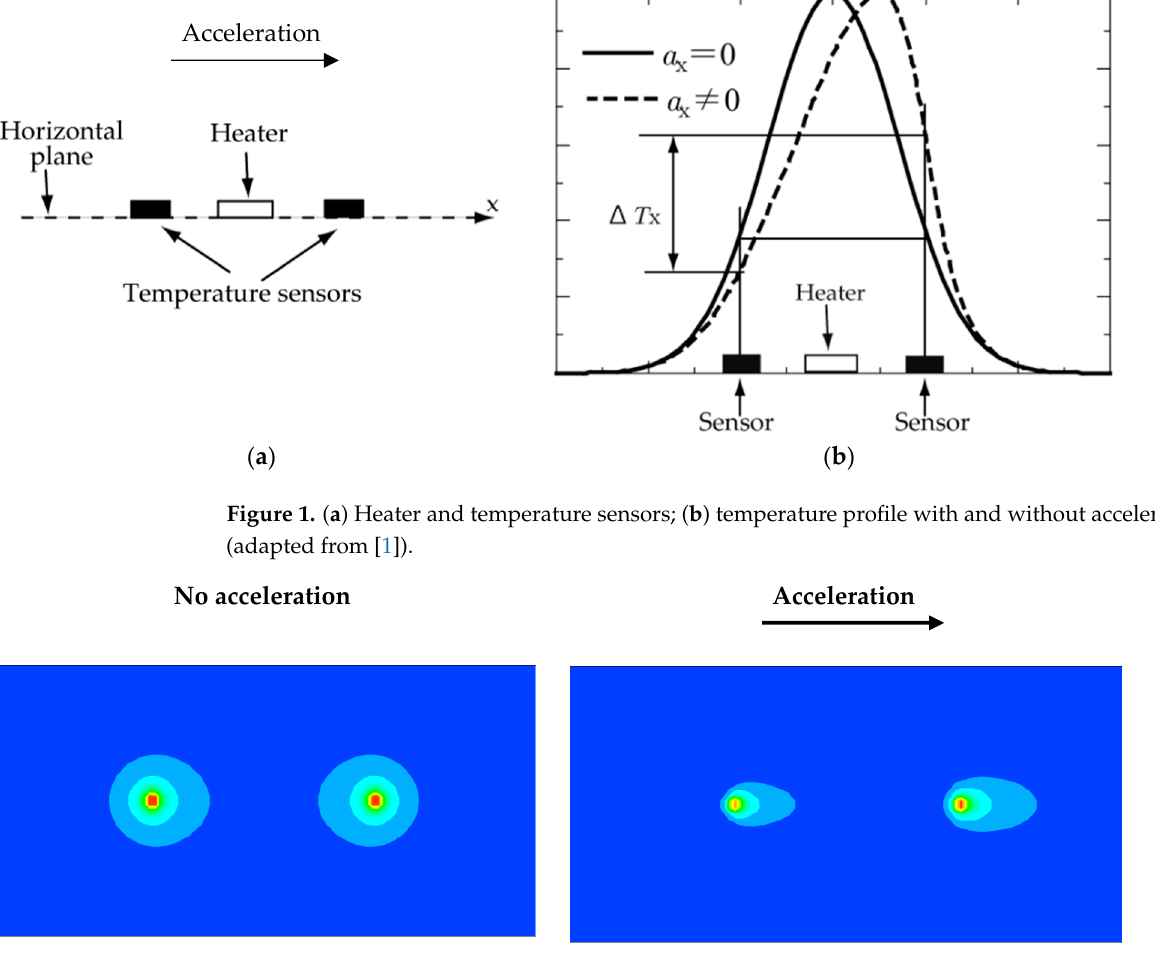
Figure 2. Temperature profile without acceleration ( left ) and with applied acceleration ( right ).